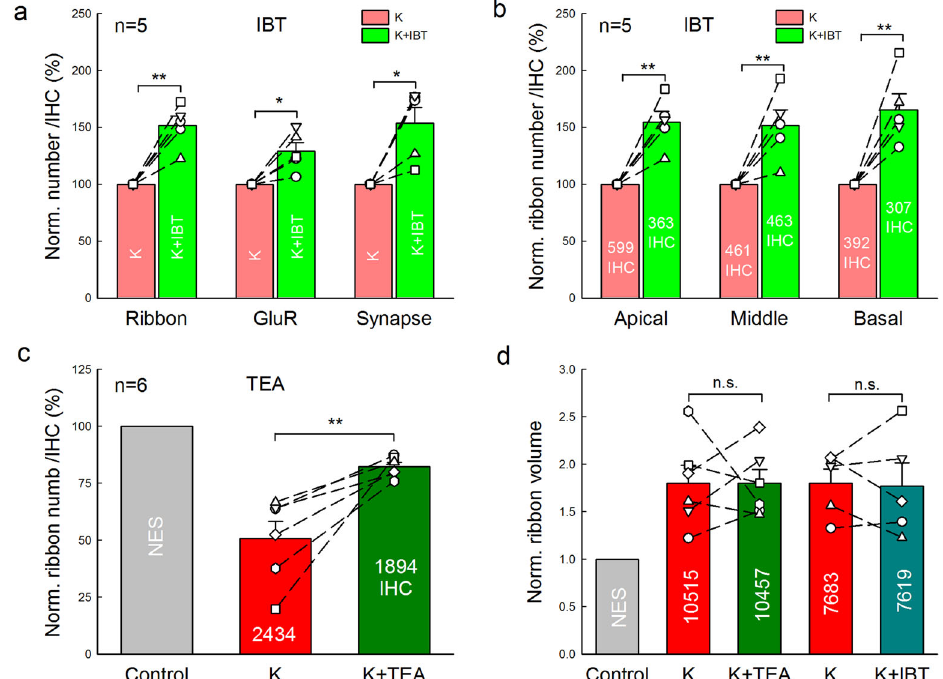
Fig. 3 Attenuation of IHC ribbon synapse degeneration by K + channel blockers. a Attenuation of the BK channel blocker iberiotoxin (IBT) on K + -induced IHC ribbon synapse degeneration. One cochlea was incubated in 50 mM K + extracellular solution (high-K + group) and another cochlea of the same mouse was incubated in 50 mM K + extracellular solution with 0.1 μ M IBT (K + + IBT group). Both cochleas were simultaneously incubated for 2 h. The numbers of presynaptic ribbons, postsynaptic GluRs, and synapses per IHC from all cochlear turns were averaged and normalized to those in the high-K + group. Dashed lines connected two same symbols represent data collected from two cochleas of the same mouse. N is the mouse number. b Attenuation of ribbon degeneration by IBT in different cochlear turns. Total numbers of accounted IHCs are presented in each bar. c Attenuation of a K + channel blocker TEA on ribbon degeneration. Two cochleas of a mouse were incubated separately in the high-K + (50 mM) extracellular solution (high-K + group) and in the 50 mM K + extracellular solution with 20 mM TEA (K + + TEA group) for 2 h. Ribbon numbers per IHC from all cochlear turns in the high-K + group and the K + + TEA group were separately calculated and normalized to that in the NES control group in Fig. 1. Dashed lines connected two same symbols represent data collected from two cochleas of the same mouse. d IBT and TEA have no signi fi cant attenuating effect on K + -induced ribbon swelling. Ribbon volumes were pooled from all cochlear turns, and averaged and normalized to that in the NES control group in Fig. 1. Numbers in the bars represent the total numbers of measured ribbons. * P < 0.05, ** P < 0.01, n.s. no signi fi cance ( P > 0.05), paired t -test, two-tail for all